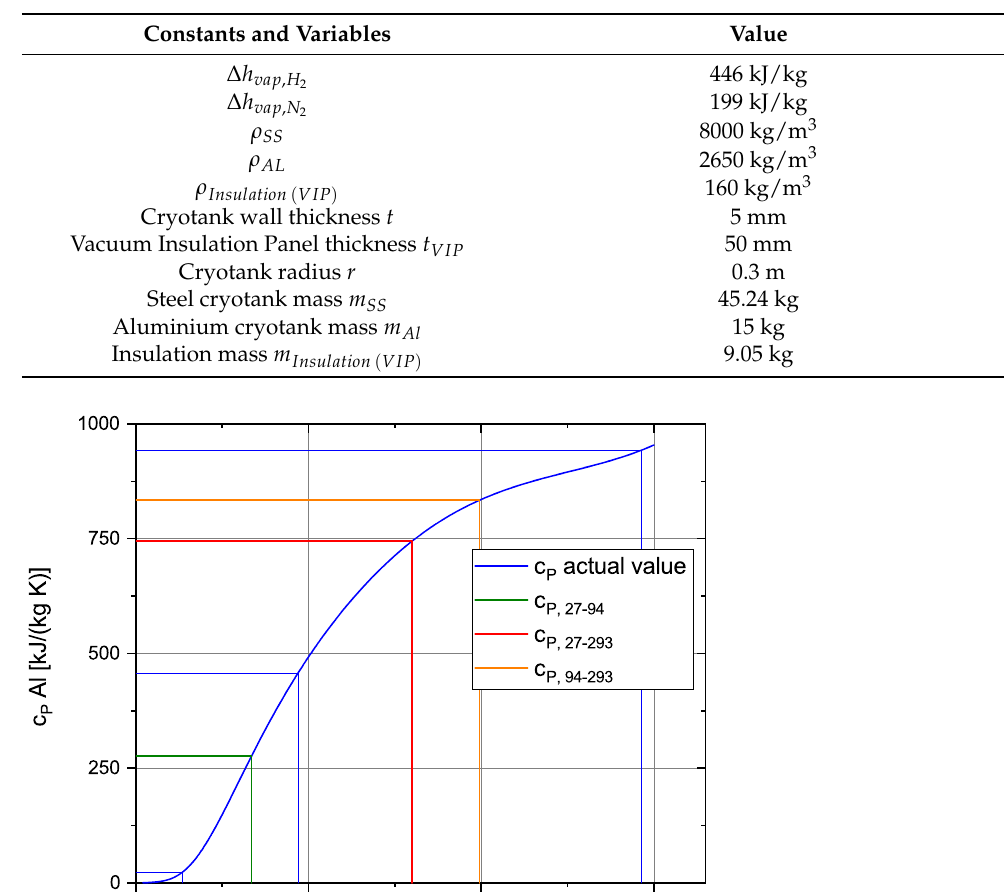
for different temperature AL